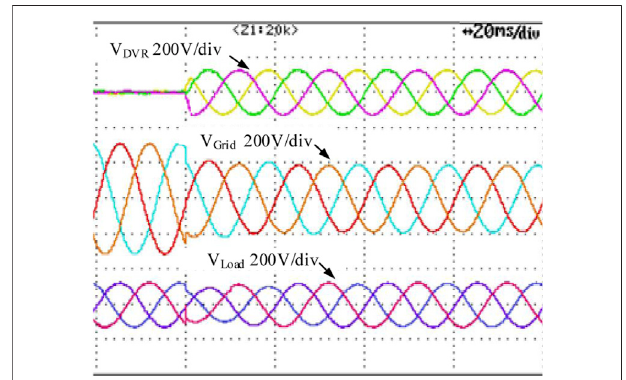
FIGURE 13 | Experimental setup for voltage sag compensation.